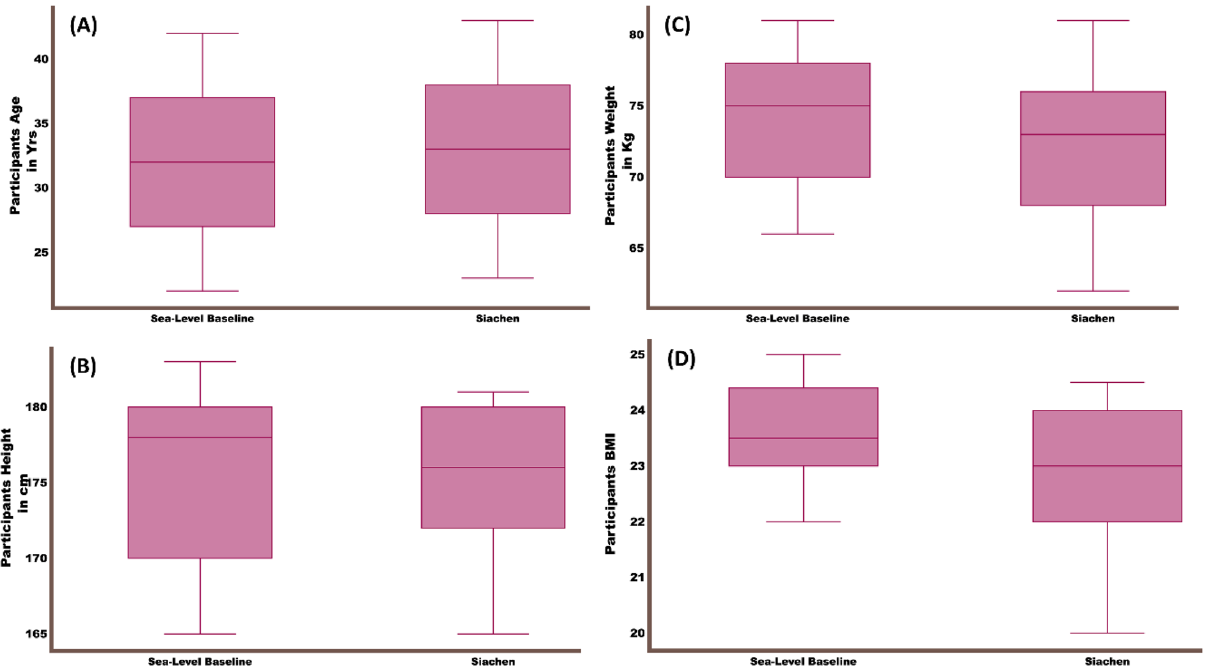
Figure 1. The summary of demographic and clinical data of the